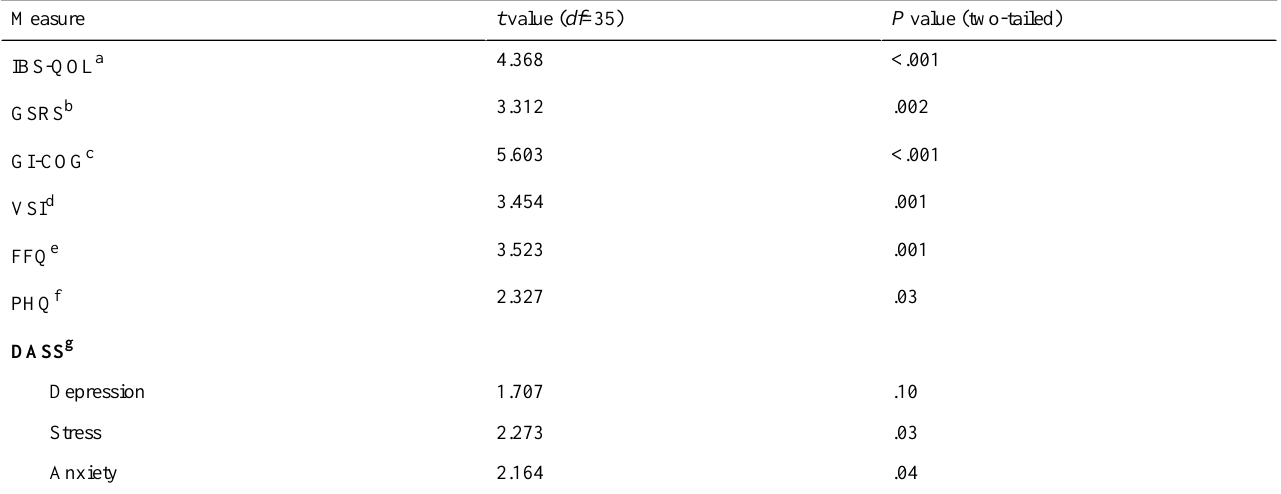
Table 3. Improvement from baseline to posttreatment for the immediate treatment